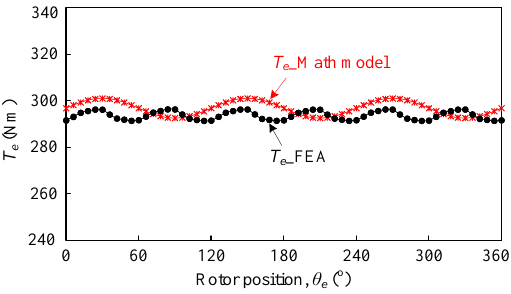
Figure 9. Electromagnetic torque waveforms. Table 4. Characteristics of electromagnetic torque.